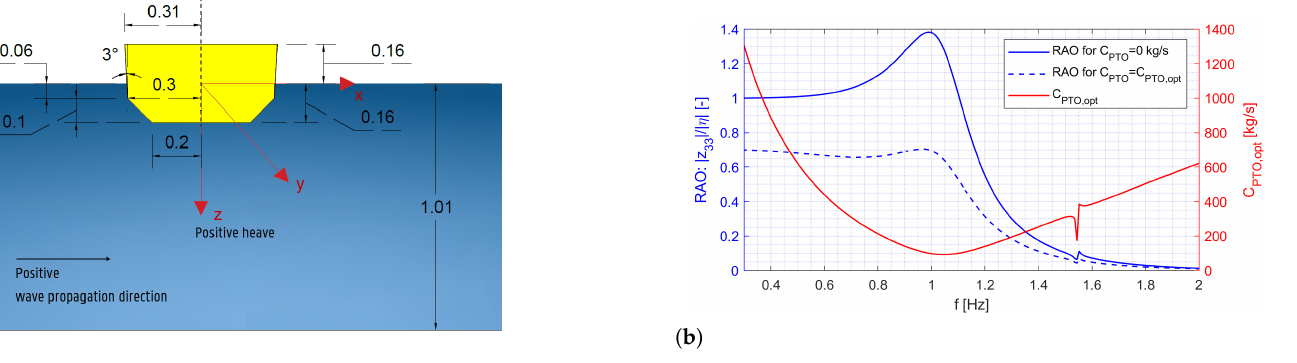
Figure 18. WECfarm’s WEC’s buoy: ( a ) 2D rendering with dimensions in m; ( b ) RAO and C PTO , opt